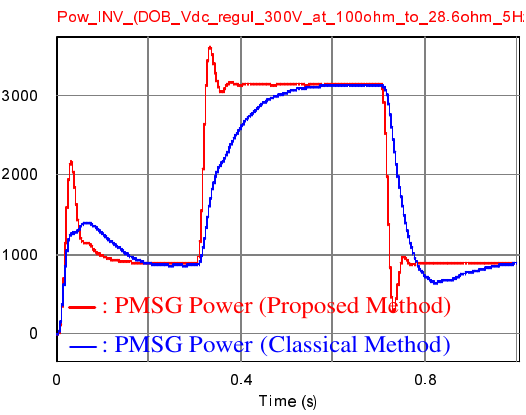
Figure 6. The permanent magnet synchronous generator (PMSG) output power behaviors of the proposed method and the feedback linearizing (FL) method at the DC-link voltage of 300 V with a pulse resistive load torque from R L = 100 Ω to R L = 28.6 Ω .